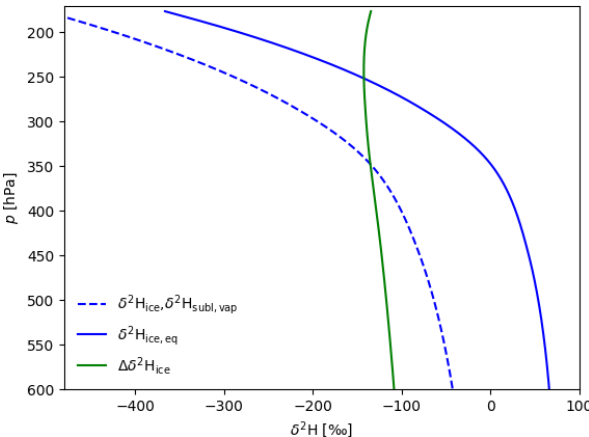
Figure A1. (cid:49)δ 2 H ice (green line) obtained from a hypothetical ex- periment in which ice with the isotope composition δ 2 H ice is in- serted into a totally dry environment, moistened by the sublimation of ice only. Equilibrium ice δ 2 H ice , eq from this newly formed water vapour is shown by the thick blue line. The δ 2 H ice profile in this example follows a Rayleigh curve obtained from a moist adiabatic ascent (dashed thick blue line) with T 0 = 30 ◦ C at 1000hPa.